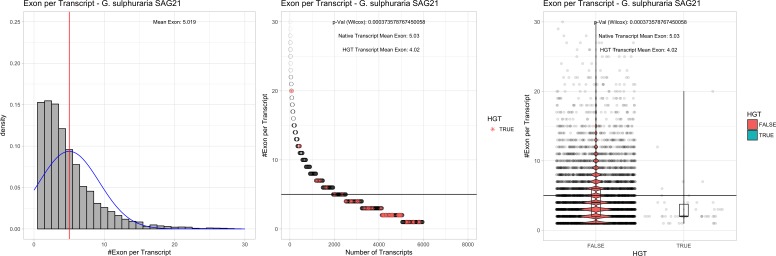
Exon/Intron – Galdieria sulphuraria SAG21: (Left) Mid) Cumulative %GC distribution of transcripts.Red line shows the average, blue line a normal distribution based on the average value. The data is categorical (genes have either one, two, three etc. exons) and does not follow a normal distribution. (Mid) Ranking all transcripts based upon their number of exons. Red ‘*' demarks HGT candidates. As the number of exons was not normally distributed, transcripts were ranked by number of exons. In order to resolve the high number of tied ranks (e.g. many transcripts have two exons) a bootstrap was implied by which the rank of transcripts sharing the same number of exons was randomly assigned 1000 times. Wilcoxon-Mann-Whitney-Test applied for the determination of significant rank differences between the native gene and the HGT candidate subset. (Right) Violin plot showing the number of exons per transcript distribution across native transcripts and HGT candidates.